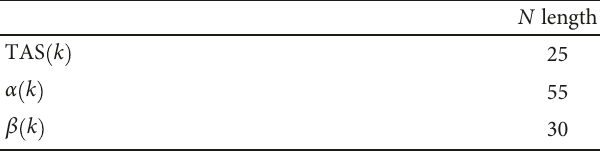
Table 5: Filter length and whitening fi lter